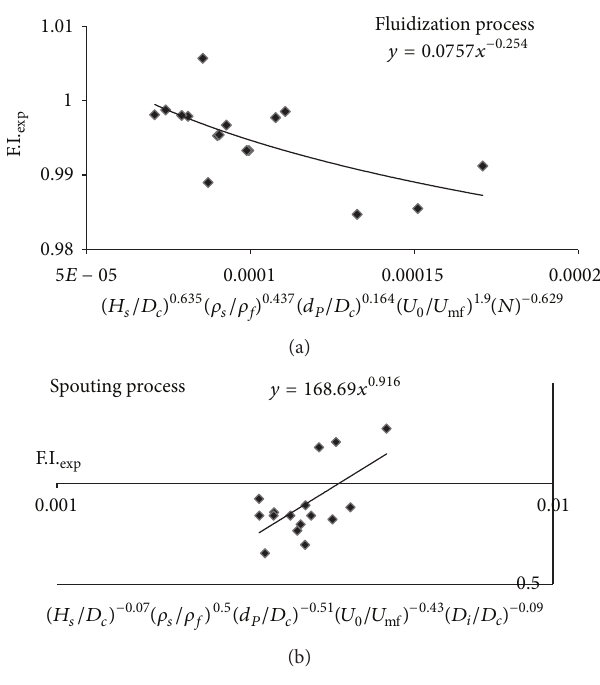
Figure 9: Correlation plot of bed fluidization index against system parameters for fine